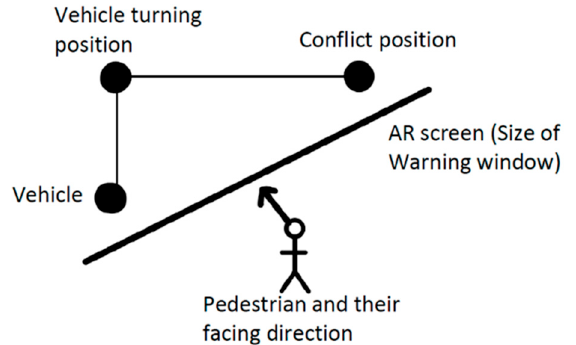
Figure 5. Basic turning scenario.